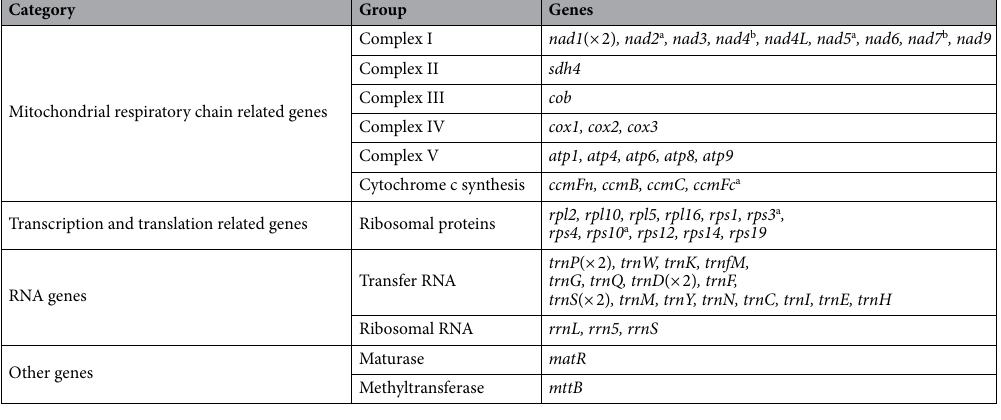
Table 1. Gene annotation of the G. sinensis mt genome. a Genes with one intron, b genes with at least two introns.